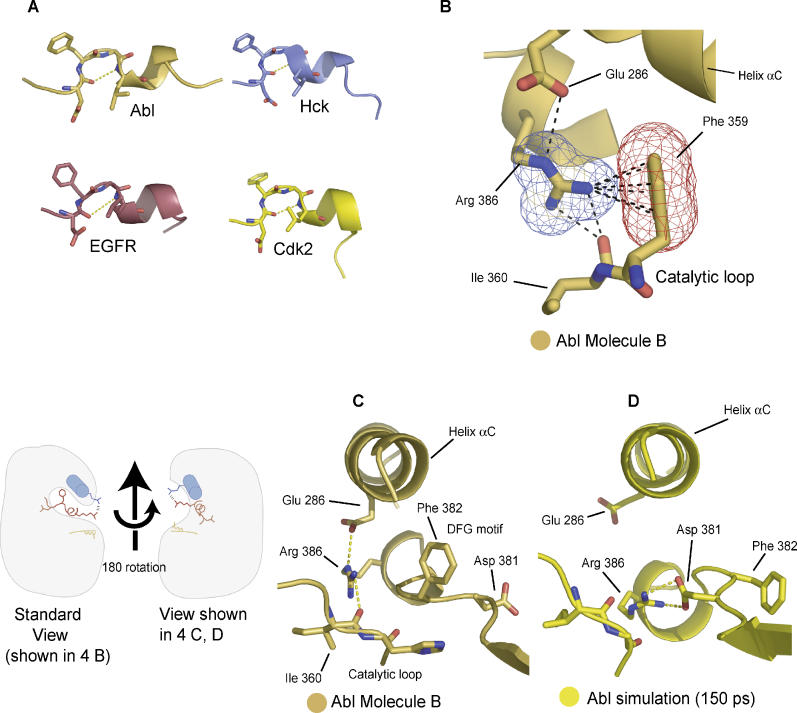
The Helical Turn following the DFG motif in Src-Like Inactive Structures(A) The helical turn in the activation loop of molecule B that immediately follows the DFG motif is a characteristic feature of the Src-like conformation and is conserved in four different kinase families.(B and C) The side chain of Arg 386, presented by the helical turn, forms a hydrogen bond to a backbone carbonyl of Ile 360, a salt bridge with Glu 286, and an amino–aromatic interaction with Phe 359 that positions it for interacting with Asp 381 during the DFG flip.(D) An intermediate structure during one of the TMD simulations, showing the capture of Asp 381 by Arg 386.